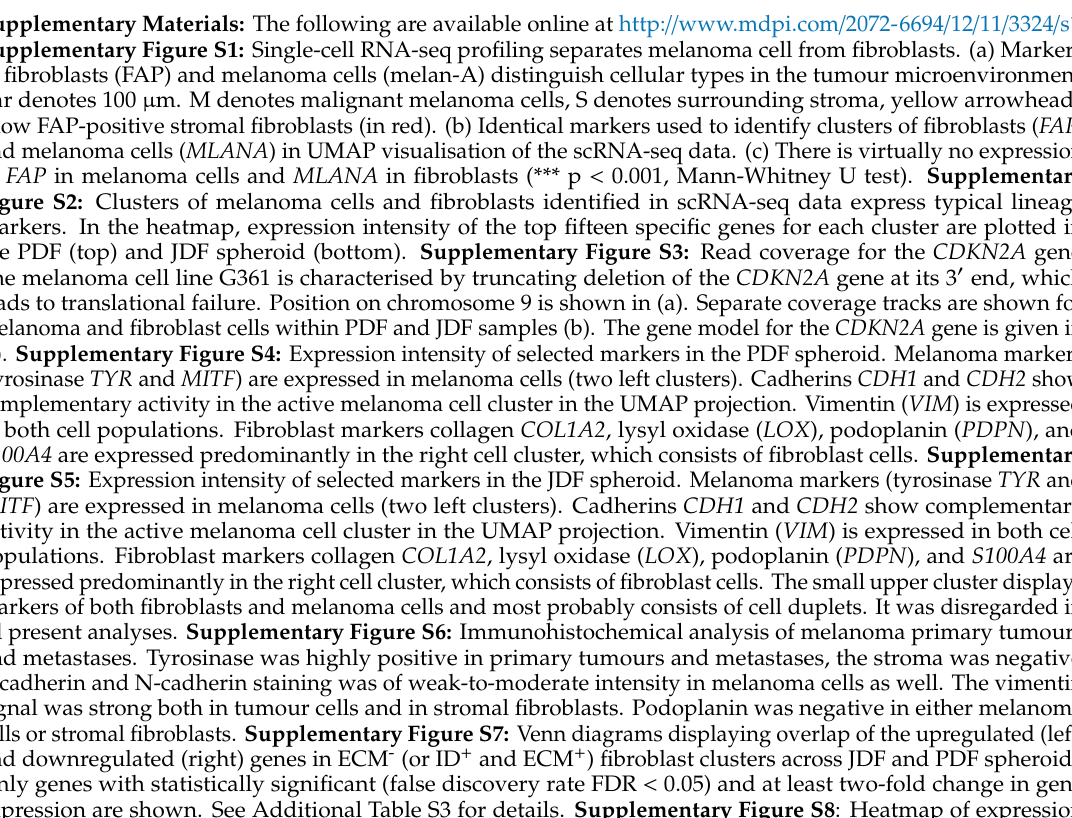
Supplementary Figure S1: Single-cell RNA-seq profiling separates melanoma cell from fibroblasts. (a) Markers of fibroblasts (FAP) and melanoma cells (melan-A) distinguish cellular types in the tumour microenvironment. Bar denotes 100 µ m. M denotes malignant melanoma cells, S denotes surrounding stroma, yellow arrowheads show FAP-positive stromal fibroblasts (in red). (b) Identical markers used to identify clusters of fibroblasts ( FAP ) and melanoma cells ( MLANA ) in UMAP visualisation of the scRNA-seq data. (c) There is virtually no expression of FAP in melanoma cells and MLANA in fibroblasts (*** p < 0.001, Mann-Whitney U test). Supplementary Figure S2: Clusters of melanoma cells and fibroblasts identified in scRNA-seq data express typical lineage markers. In the heatmap, expression intensity of the top fifteen specific genes for each cluster are plotted in the PDF (top) and JDF spheroid (bottom). Supplementary Figure S3: Read coverage for the CDKN2A gene. The melanoma cell line G361 is characterised by truncating deletion of the CDKN2A gene at its 3 (cid:48) end, which leads to translational failure. Position on chromosome 9 is shown in (a). Separate coverage tracks are shown for melanoma and fibroblast cells within PDF and JDF samples (b). The gene model for the CDKN2A gene is given in (c). Supplementary Figure S4: Expression intensity of selected markers in the PDF spheroid. Melanoma markers (tyrosinase TYR and MITF ) are expressed in melanoma cells (two left clusters). Cadherins CDH1 and CDH2 show complementary activity in the active melanoma cell cluster in the UMAP projection. Vimentin ( VIM ) is expressed in both cell populations. Fibroblast markers collagen COL1A2 , lysyl oxidase ( LOX ), podoplanin ( PDPN ), and S100A4 are expressed predominantly in the right cell cluster, which consists of fibroblast cells. Supplementary Figure S5: Expression intensity of selected markers in the JDF spheroid. Melanoma markers (tyrosinase TYR and MITF ) are expressed in melanoma cells (two left clusters). Cadherins CDH1 and CDH2 show complementary activity in the active melanoma cell cluster in the UMAP projection. Vimentin ( VIM ) is expressed in both cell populations. Fibroblast markers collagen COL1A2 , lysyl oxidase ( LOX ), podoplanin ( PDPN ), and S100A4 are expressed predominantly in the right cell cluster, which consists of fibroblast cells. The small upper cluster displays markers of both fibroblasts and melanoma cells and most probably consists of cell duplets. It was disregarded in all present analyses. Supplementary Figure S6: Immunohistochemical analysis of melanoma primary tumours and metastases. Tyrosinase was highly positive in primary tumours and metastases, the stroma was negative. E-cadherin and N-cadherin staining was of weak-to-moderate intensity in melanoma cells as well. The vimentin signal was strong both in tumour cells and in stromal fibroblasts. Podoplanin was negative in either melanoma cells or stromal fibroblasts. Supplementary Figure S7: Venn diagrams displaying overlap of the upregulated (left) and downregulated (right) genes in ECM - (or ID + and ECM + ) fibroblast clusters across JDF and PDF spheroids. Only genes with statistically significant (false discovery rate FDR < 0.05) and at least two-fold change in gene expression are shown. See Additional Table S3 for details. Supplementary Figure S8 : Heatmap of